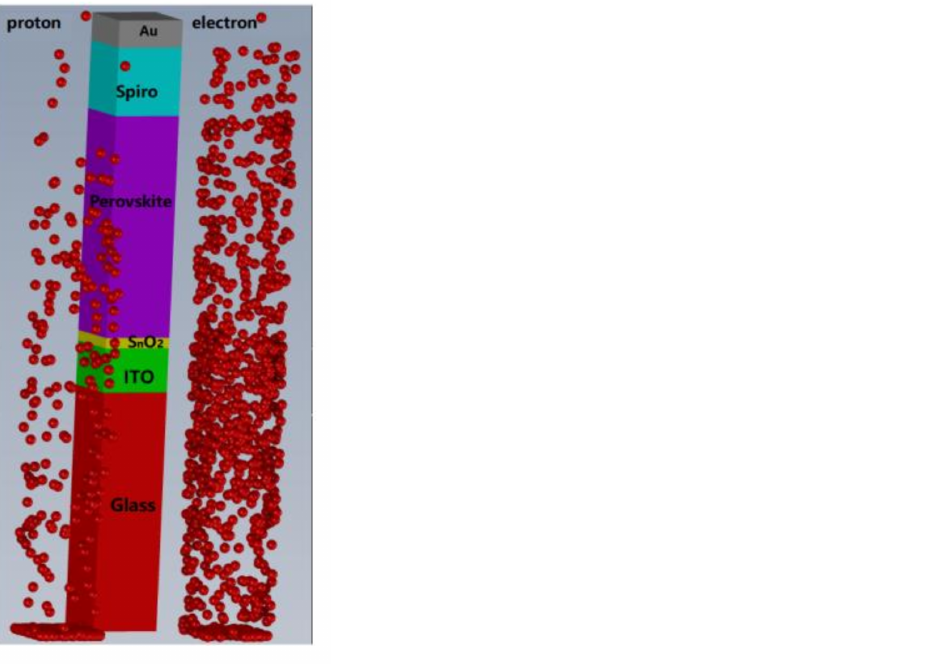
Figure 4. A 3D view showing 1 MeV electrons and 3 MeV protons reacting with the perovskite solar cell.